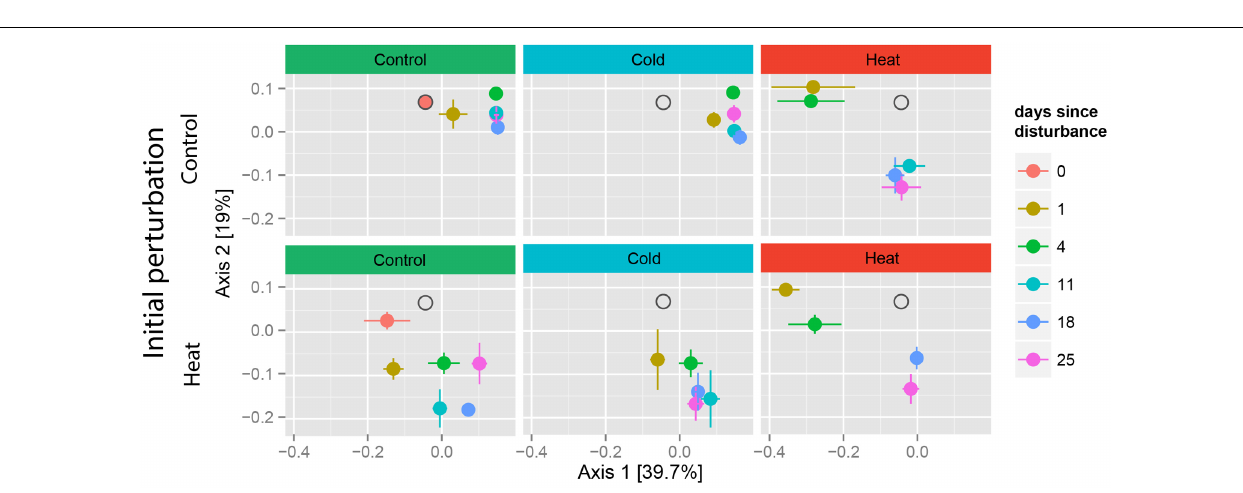
FIGURE 3 | Recovery trajectories of community composition over time. Principle coordinates analysis (PCoA) of weighted Unifrac distances between samples. A single PCoA was separated according to disturbance type and soil history. Pre-disturbance controls (0 days) are only shown for undisturbed treatments. Gray hollow circles indicate the location of samples from the T0 controls, for reference. A list of the samples lost during extraction and processing is included in Supplementary Table